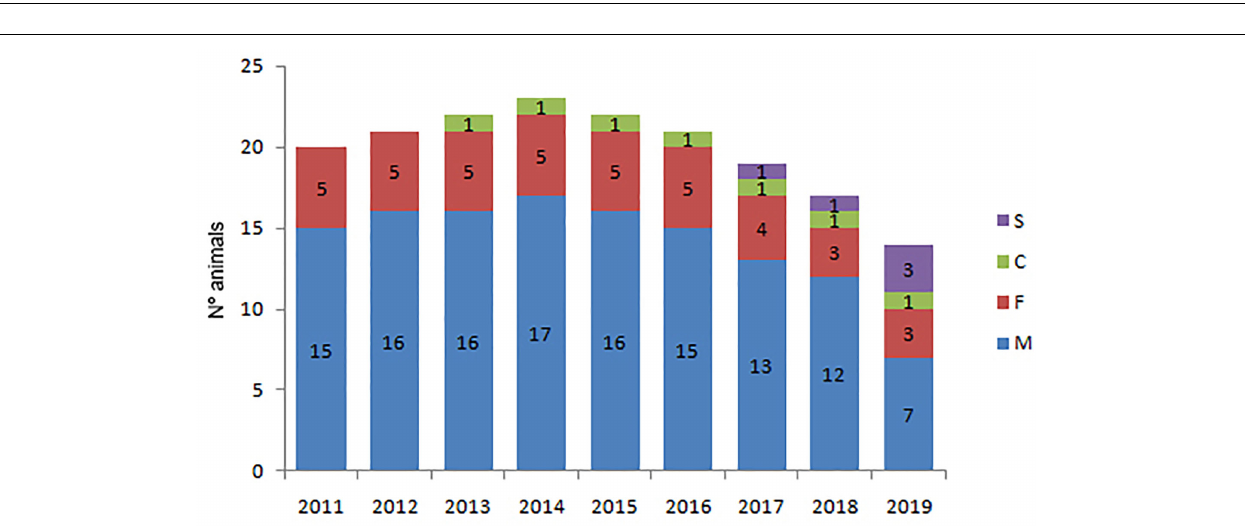
FIGURE 5 | Annual population estimates of the El Morro dolphin community. Resident dolphins in blue and non-resident dolphins in red. The green line indicates the number of trips per year conducted within the distribution area of this dolphin community. Period 2013–2019.